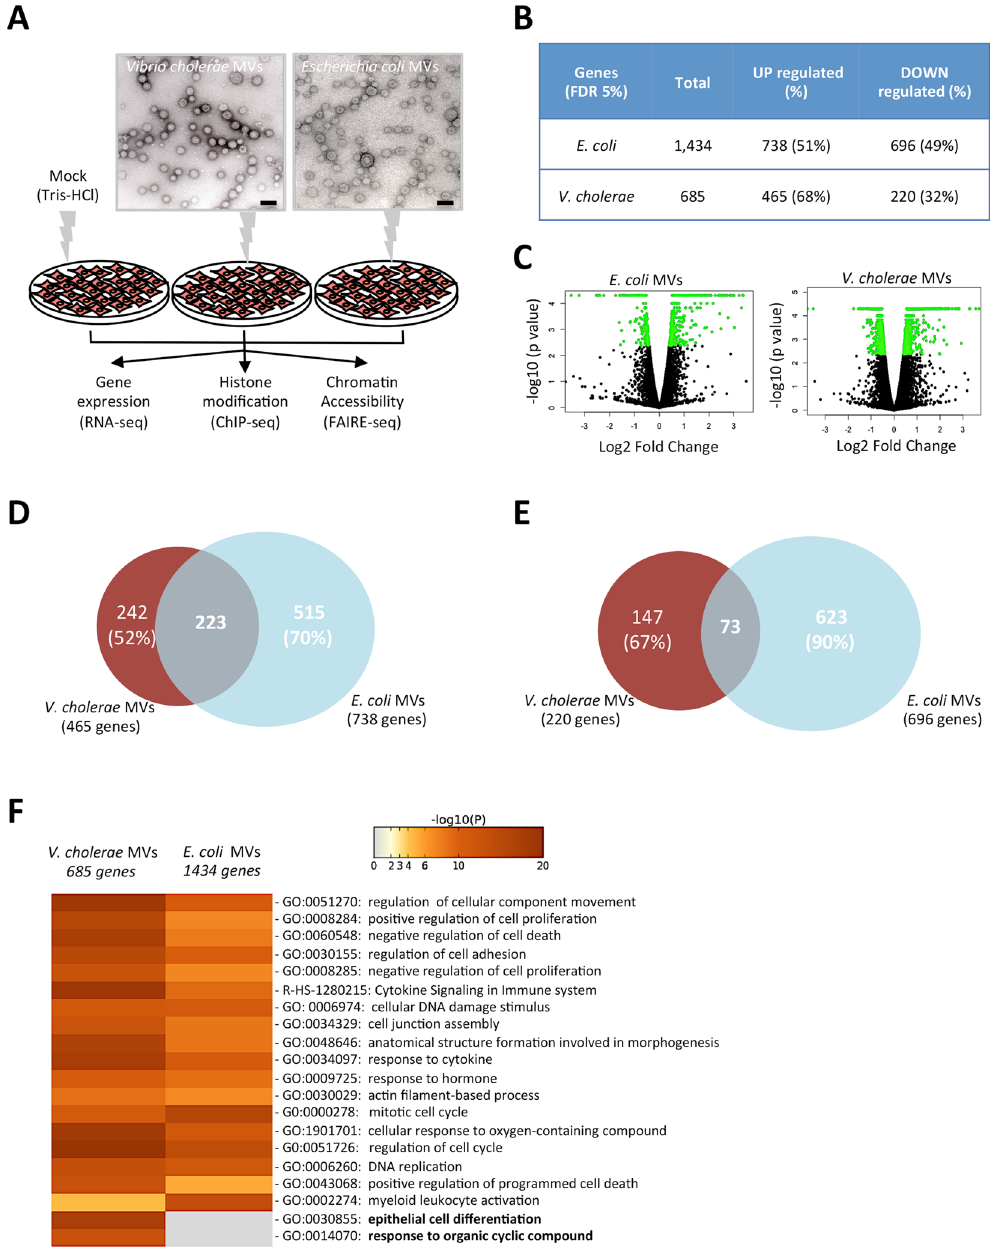
Figure 1. Bacterial membrane vesicles (MVs) target the gene transcription of HCT8 colorectal carcinoma cell line. ( A ) HCT8 cells were co-cultured with MVs from E. coli , V. cholerae or mock-treated (control) for 5 hours. The setup of the study with the following methods is shown: RNA sequencing, ChIP sequencing (H3K4me3) and FAIRE sequencing (nucleosome-free DNA), Bars; 200 nm. ( B ) Table of RNA transcripts significantly regulated by MVs from E. coli or V. cholerae compared to mock. ( C ) Volcano plots of differentially regulated host cell genes by MVs from E. coli or V. cholerae compared to mock. ( D ) Venn Diagram showing the overlap of upregulated genes between HCT8 cells co-cultured with MVs from E. coli and V. cholerae . ( E ) Venn Diagram showing the overlap of downregulated genes between HCT8 cells co-cultured with MVs from E. coli and V. cholerae . ( F ) Gene ontology enriched terms for genes differentially regulated in HCT8 cells co-cultured with MVs from E. coli or V. cholerae